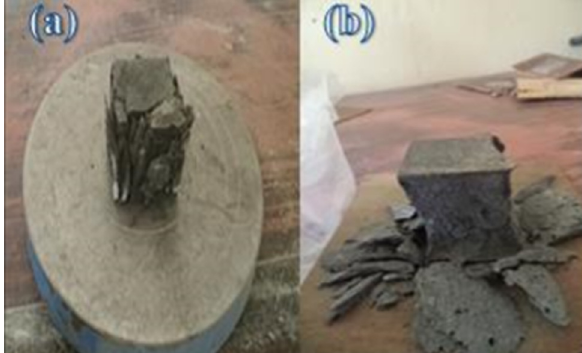
Figure 7: Failure shape of concrete cubes ( a ) with steel fi ber, ( b ) without steel